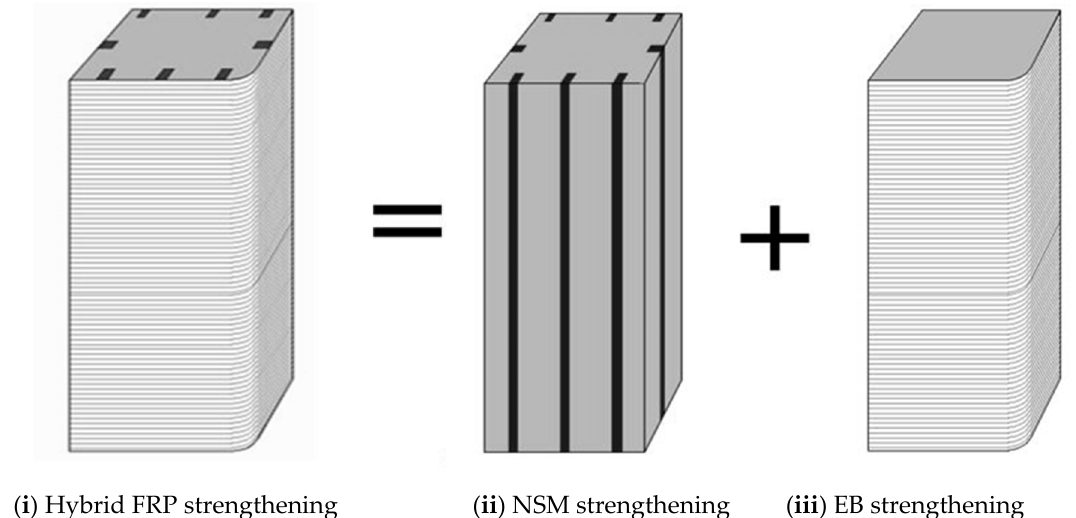
Figure 4. Schematics of Hybrid FRP strengthening of column.